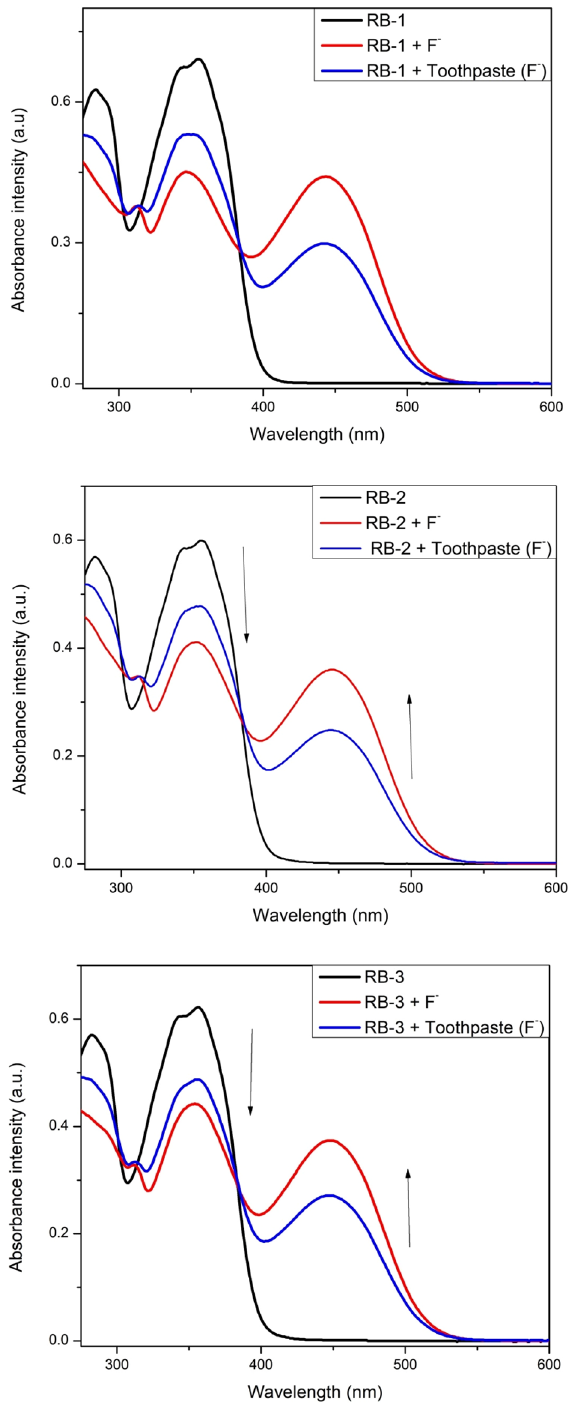
Figure 4. UV–Vis spectra of chemosensors RB-1, RB-2 and RB-3 in CH 3 CN after addition of toothpaste sample (F − ions) (50